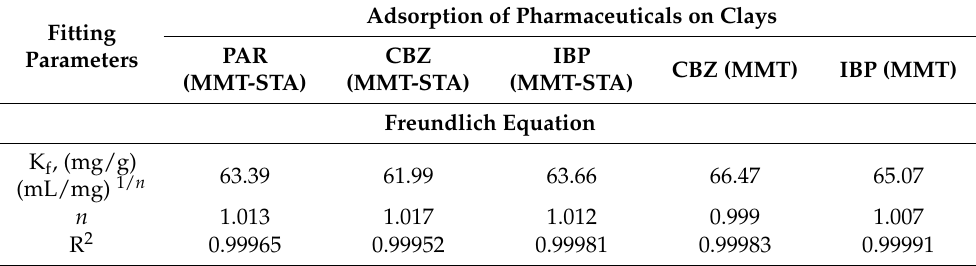
Table 2. Parameters of the Freundlich equation obtained in the analysis of adsorption isotherms of pharmaceuticals. Fitting Parameters